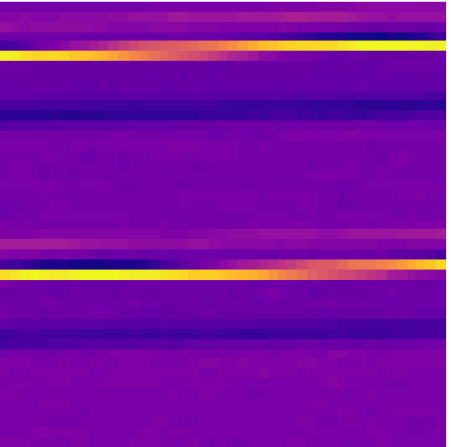
Figure 5. Original sample from the first signal ‘i’ of an electrocardiogram processed into an image.